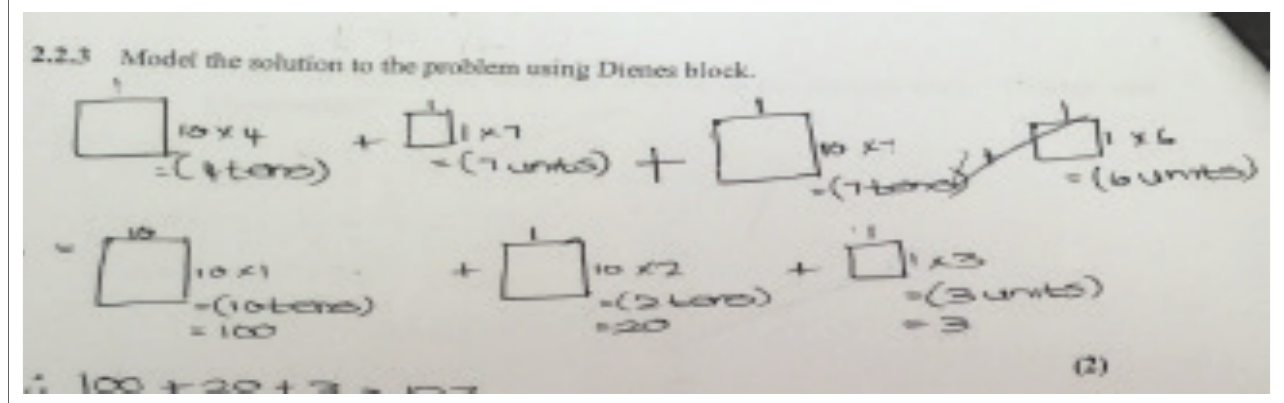
FIGURE 3: Sample of students’ written responses to item